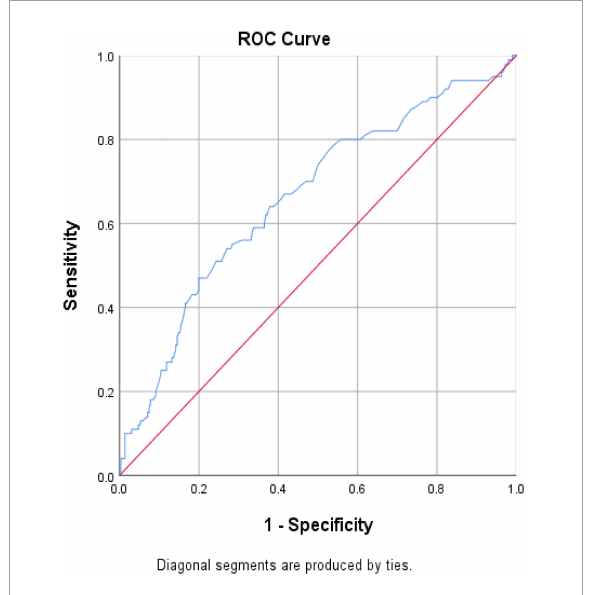
FIGURE3 ROC curve for homocysteine level as a biomarker to detect subjects with CKD. Abbreviation: CKD, chronic kidney disease; ROC, receiver operating characteristic.